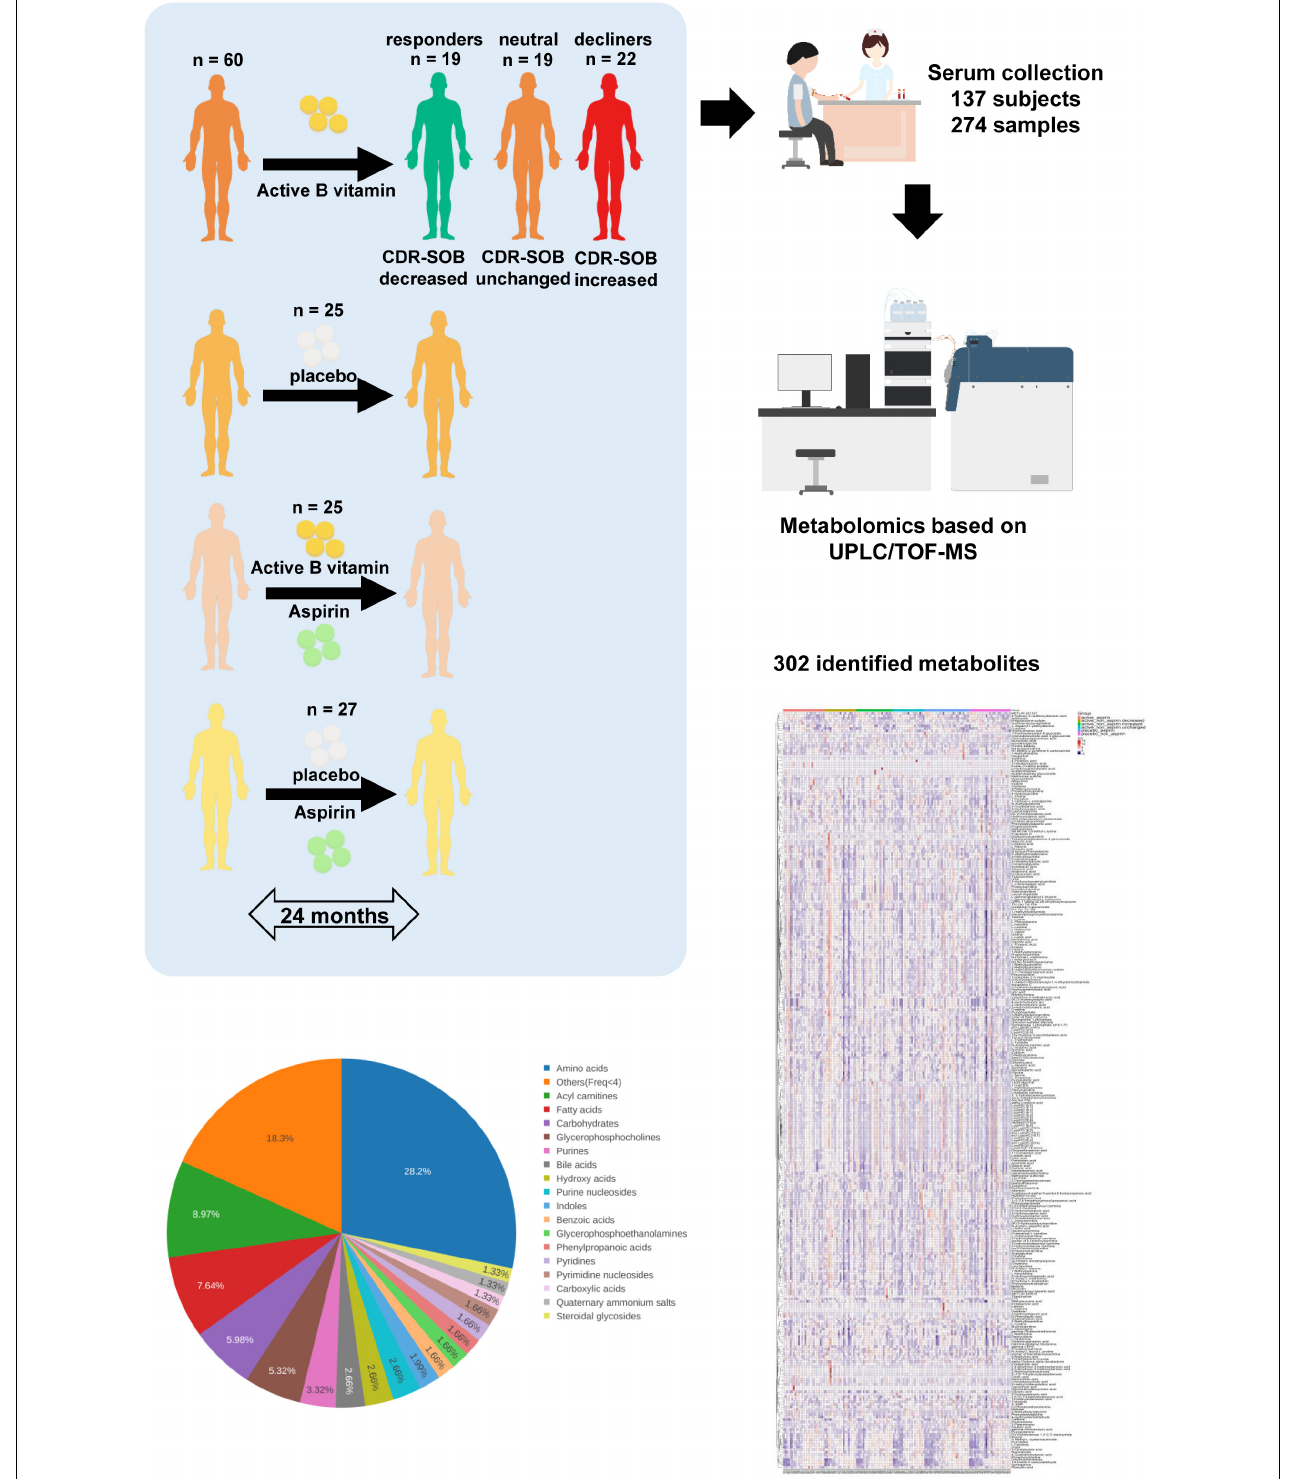
FIGURE 1 | Schematic diagram of clinical study design. Subjects were randomly assigned to active B vitamin supplementation or placebo. Aspirin usage was monitored, which further segregated the subjects into four clinical groups. To examine the molecular basis of differing responses to active B vitamin supplementation, subjects under active B vitamins, non-aspirin group were further segregated into three groups based on cognitive outcome measured by 24-month changes in CDR-SOB. Baseline and 24-month serum samples were analyzed using untargeted metabolomics covering more than 300 identified metabolites.